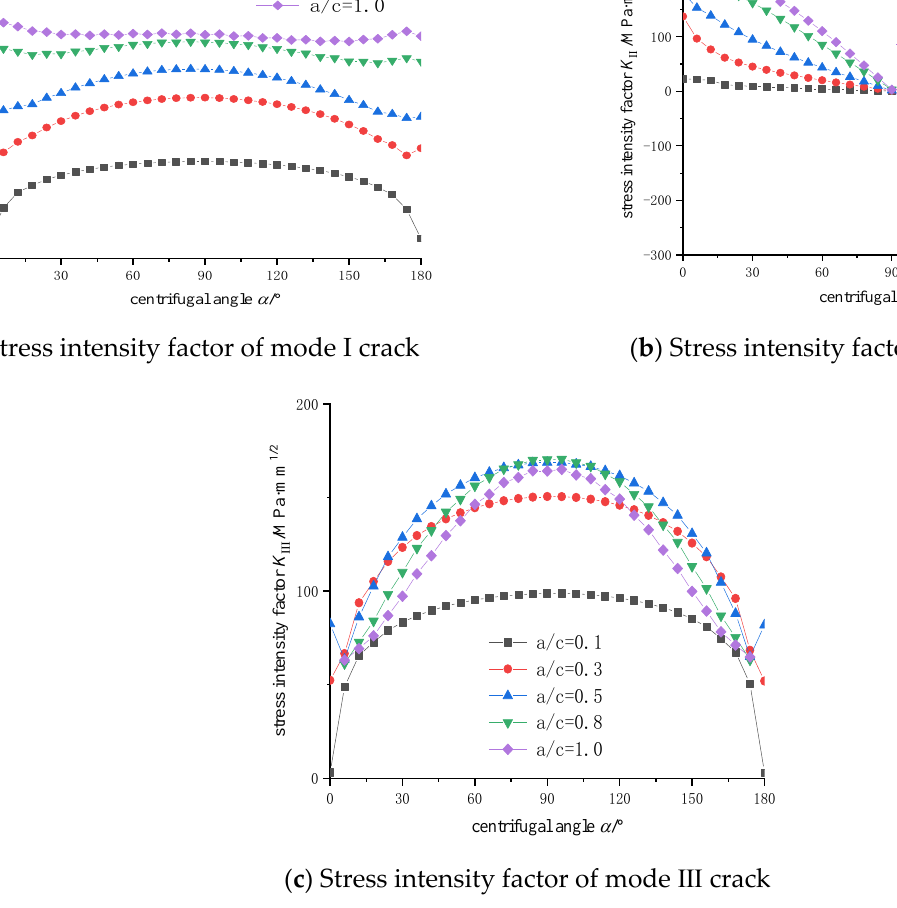
Figure 9. Stress intensity factor distribution of cracks with different shape ratio: ( a ) Stress intensity factor of mode I crack ( b ) Stress intensity factor of mode Ⅱ crack ( c ) Stress intensity factor of mode Ⅲ crack.